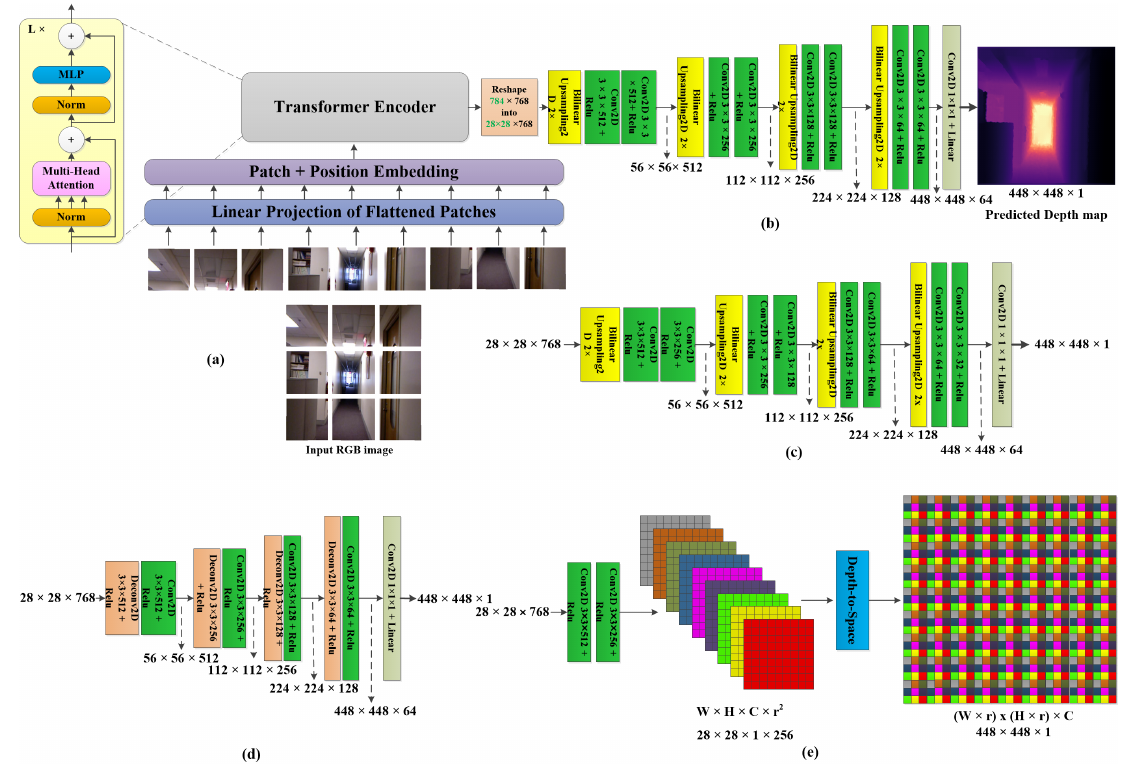
Figure 2. The proposed architectures: ( a ) The ViT encoder. ( b ) The CNN decoder with a progressive bilinear up-sampling architecture (US1), ( c ) The second CNN decoder with a progressive bilinear up-sampling architecture with a lower number of kernels in the second convolution of each block (US2), ( d ) The CNN decoder with the deconvolution up-sampling architecture (Deconv), and ( e ) The CNN decoder with the depth-to-space up-sampling architecture